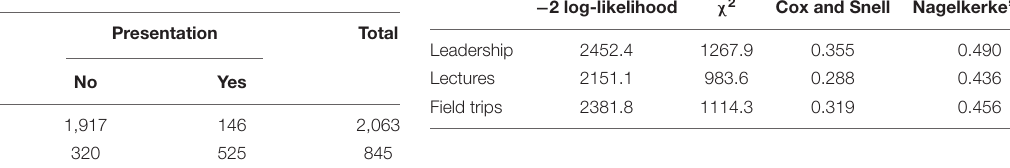
TABLE 1 | Number of participants that took over leadership in field trips or presentations about birds.